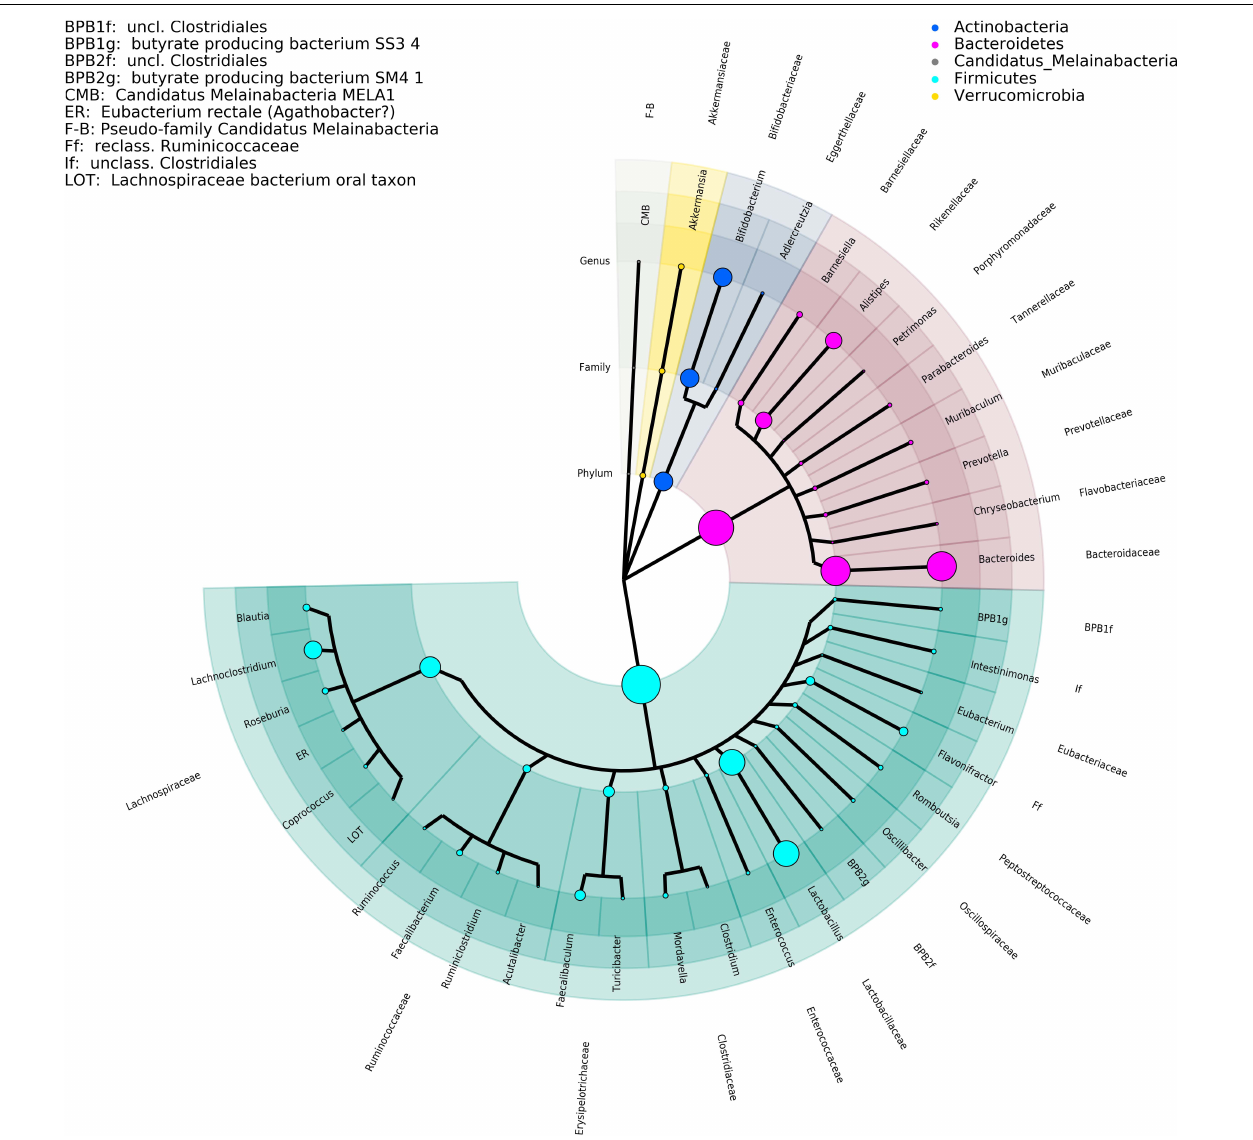
FIGURE 1 | Phylogenetic tree representing the major taxa appearing in the time-series analysis performed by DNA isolation method 1. Phylogeny data are taken from the NCBI taxonomy database, where only the taxonomic ranks of phylum, family, and genus are shown. The size of the clade markers is indicative of the average normalized read abundance for the taxon. Pseudofamilies and pseudogenera are used for organisms defined at a lower taxonomic level but lacking higher ranking